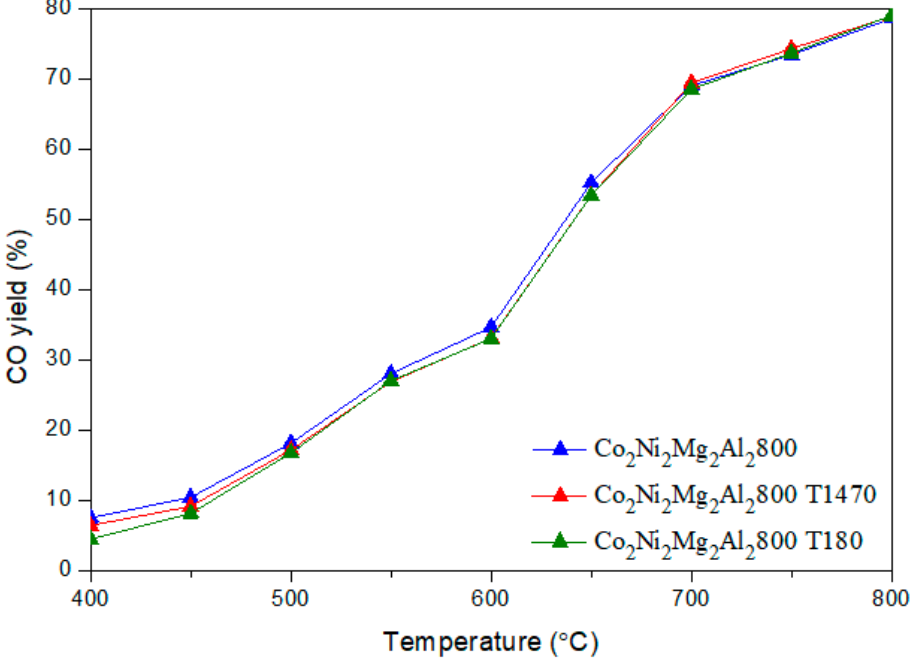
Figure 10. Evolution of the CO yield in DRM versus the reaction temperature for the catalyst Co 2 Ni 2 Mg 2 Al 2 800 with and without toluene.